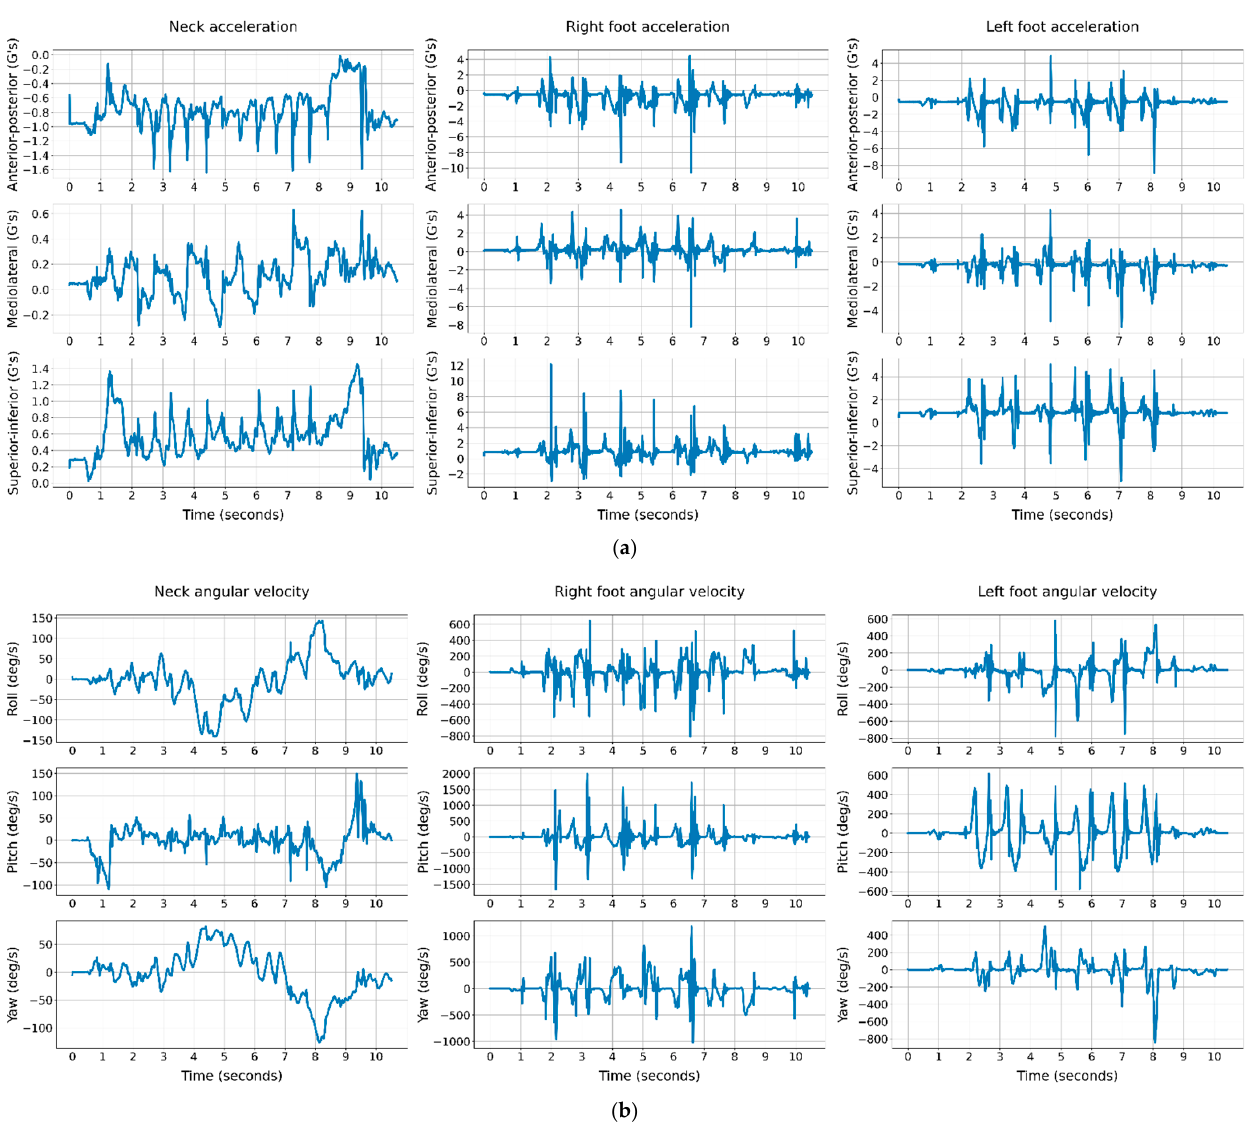
Figure 2. The neck, right and left foot kinematics signals of a subjects’ TUG test over time. ( a ) acceleration signals; ( b ) angular velocity signals.